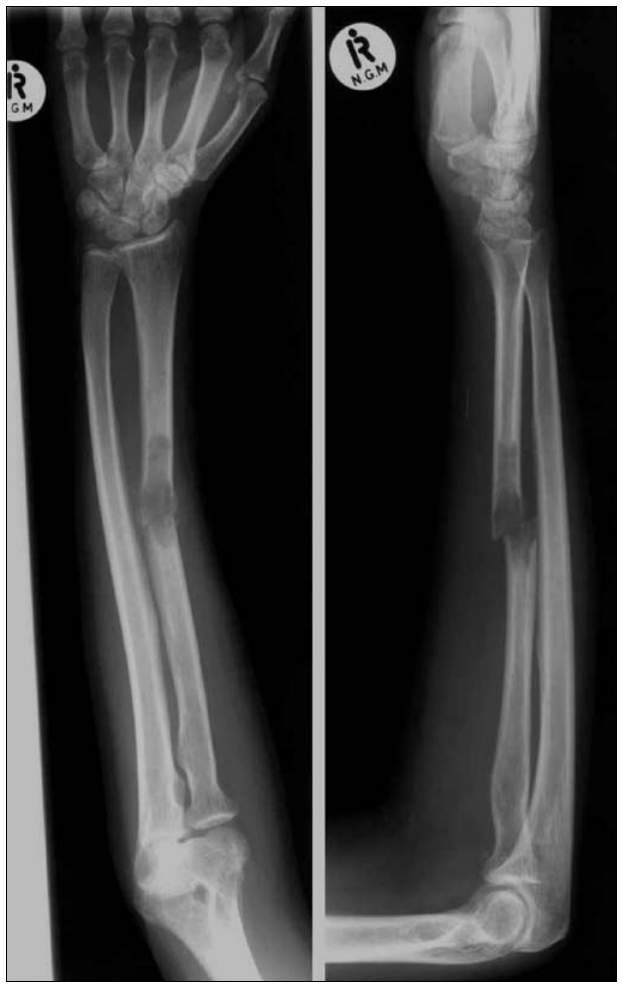
Fig.1. Plain radiographs demonstrate a multilocular lucent lesion in the mid- shaft of the right radius, complicated by pathological fracture.